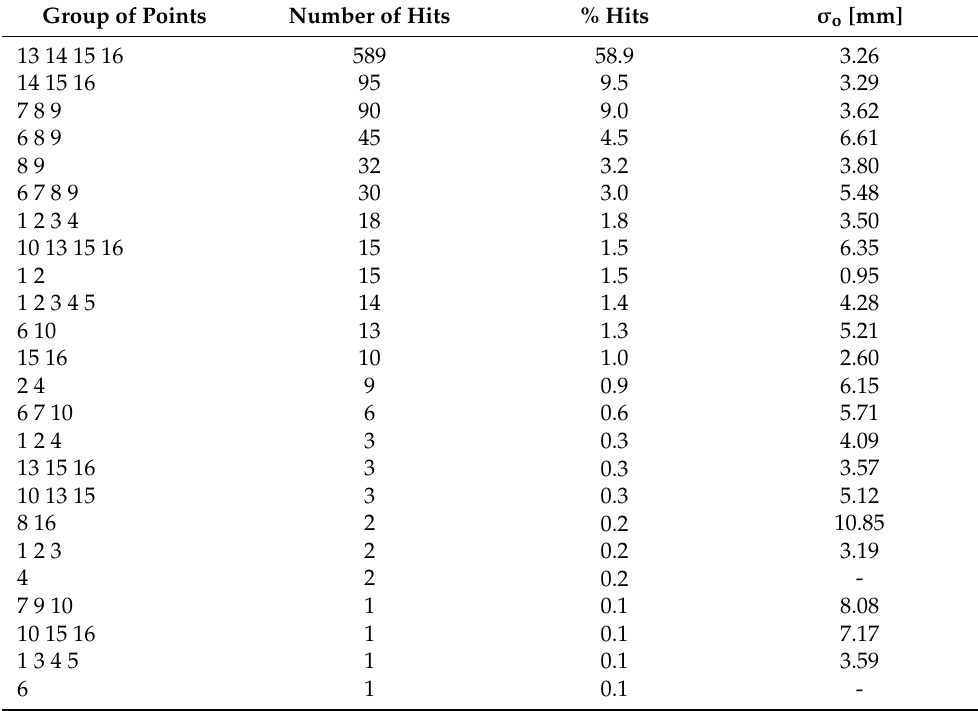
Table 7. Results of identification of the stability of reference system by the Hooke-Jeeves method for the test object